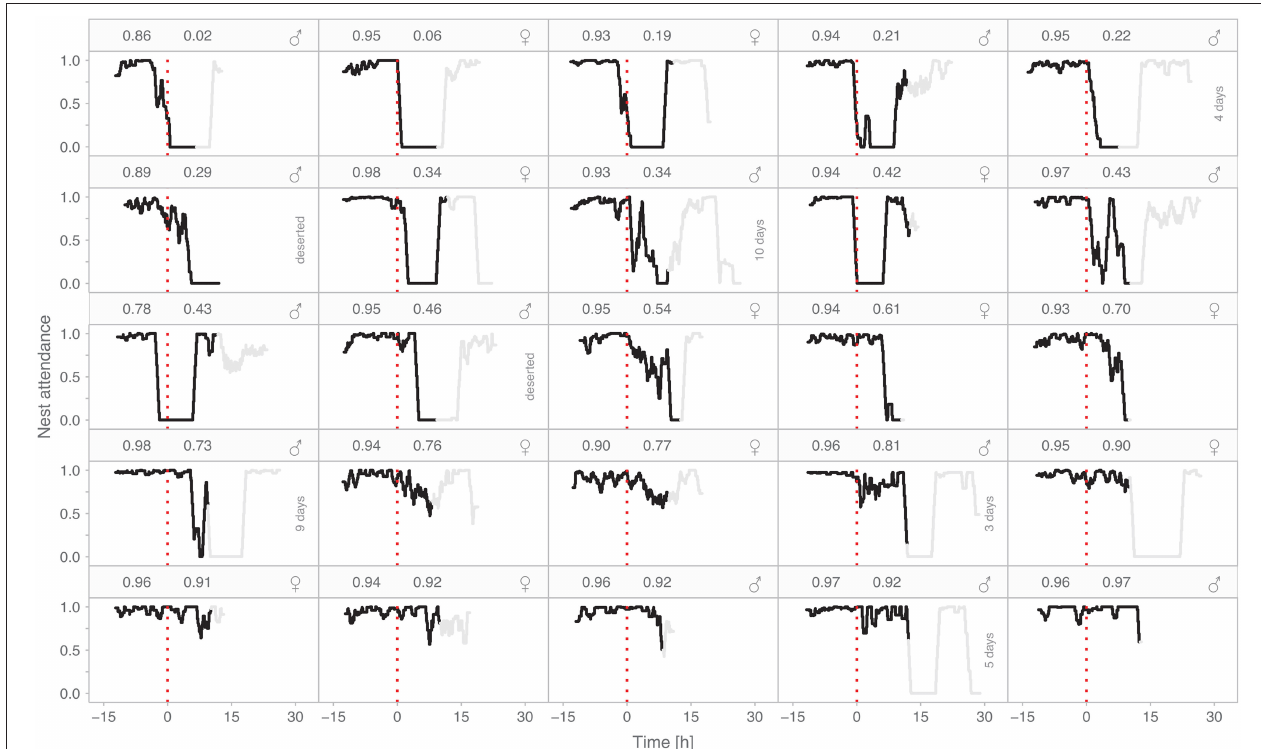
FIGURE 4 | Diverse compensation responses by individual parents in the absence of their partner. Each panel represents one of 25 focal individuals. Panels are ordered according to nest attendance within the treated period such that the individual with the lowest nest attendance is in the top-left panel. Black lines show hourly nest attendance (proportion of time the parent is on the nest, depicted as a running hourly mean) during the experimental period (i.e., from the return of the focal parent until the release of the removed parent). The red dotted lines (time zero) indicate the end of the control period (i.e., the regular incubation bout of the focal parent; negative values) and the start of the treated period (compensation period, positive values). Gray lines indicate the hourly nest attendance of the focal bird from the moment the removed parent was released until it returned to the nest. In seven nests the removed parent never returned, so we show a maximum of 30h after the start of the treated period and note whether the incubating parent deserted within this period, or for how many days the individual continued incubating